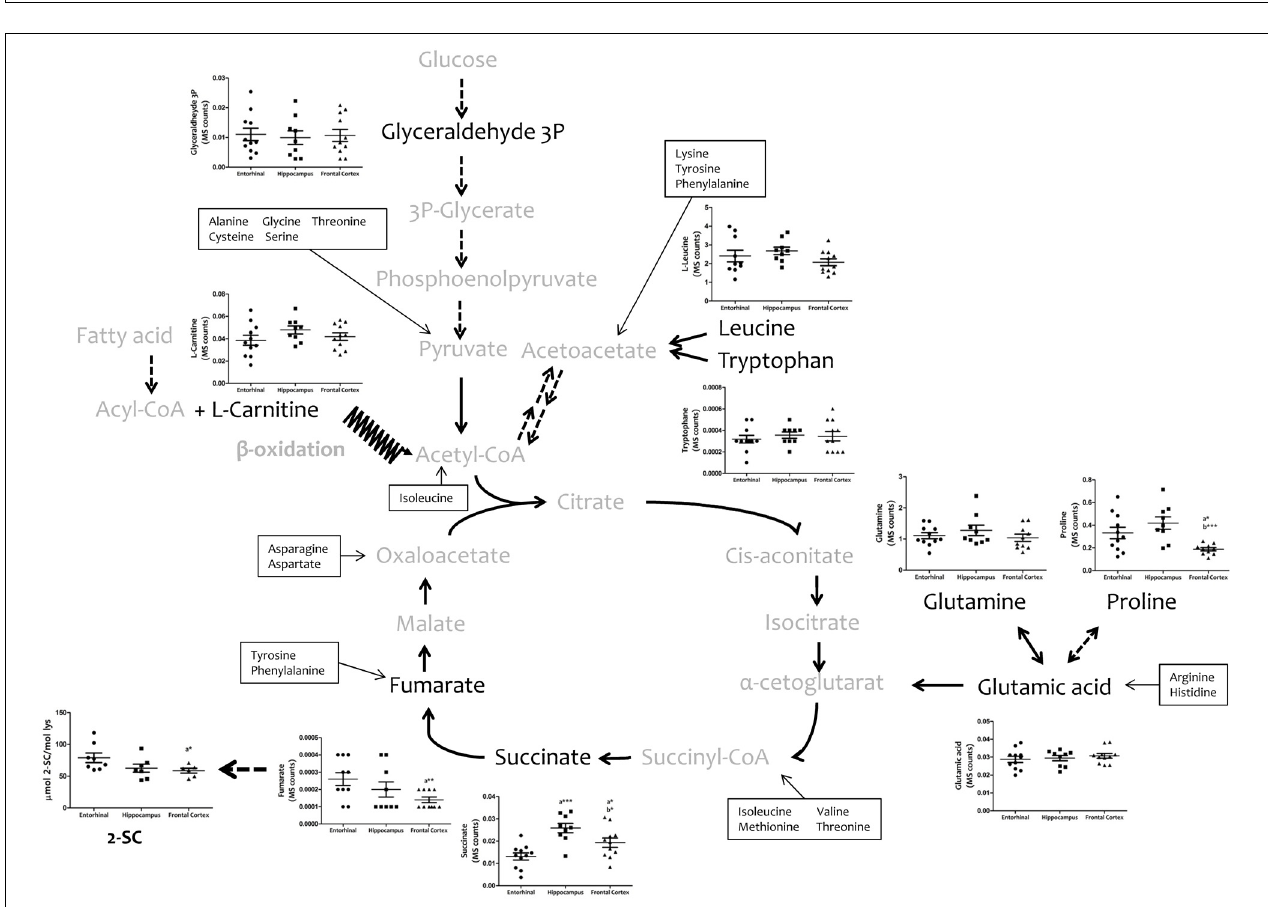
FIGURE 2 | Concentrations of metabolites involved in bioenergetics metabolism in different regions of the adult human cerebral cortex. Metabolites were detected and quantified with TQMS. The steady-state level of 2-SC was measured with GC-MS. ∗ p < 0.05; ∗∗ p < 0.01; ∗∗∗ p < 0.001. a, significant differences with respect to entorhinal cortex; b, significant differences with respect to